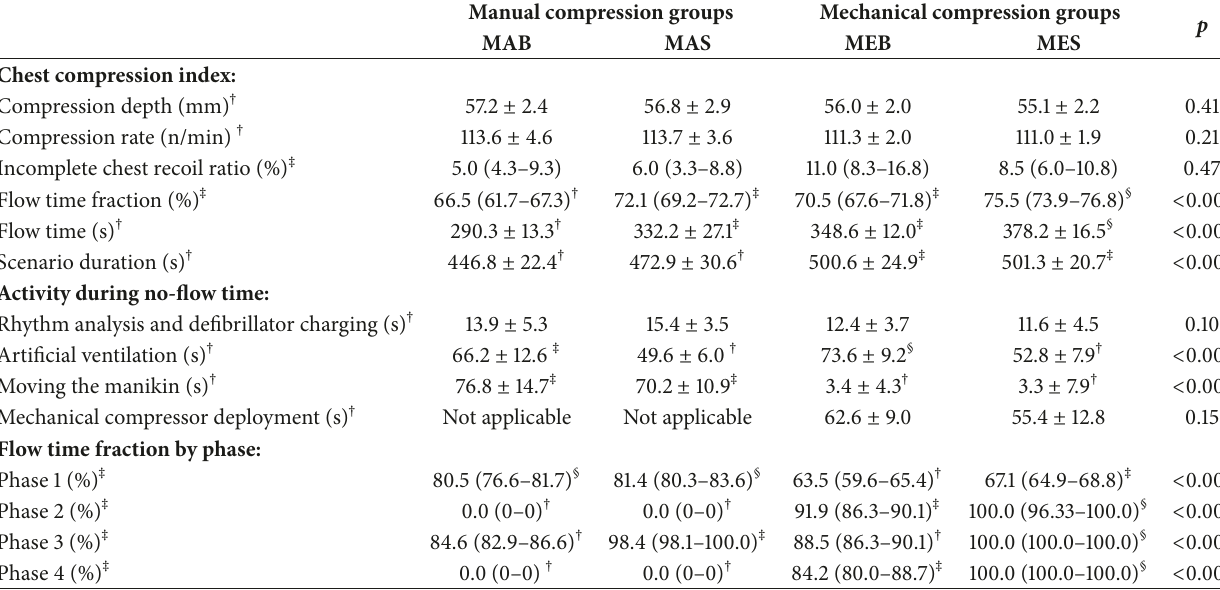
Table 2: Comparison of chest compression indices and flow